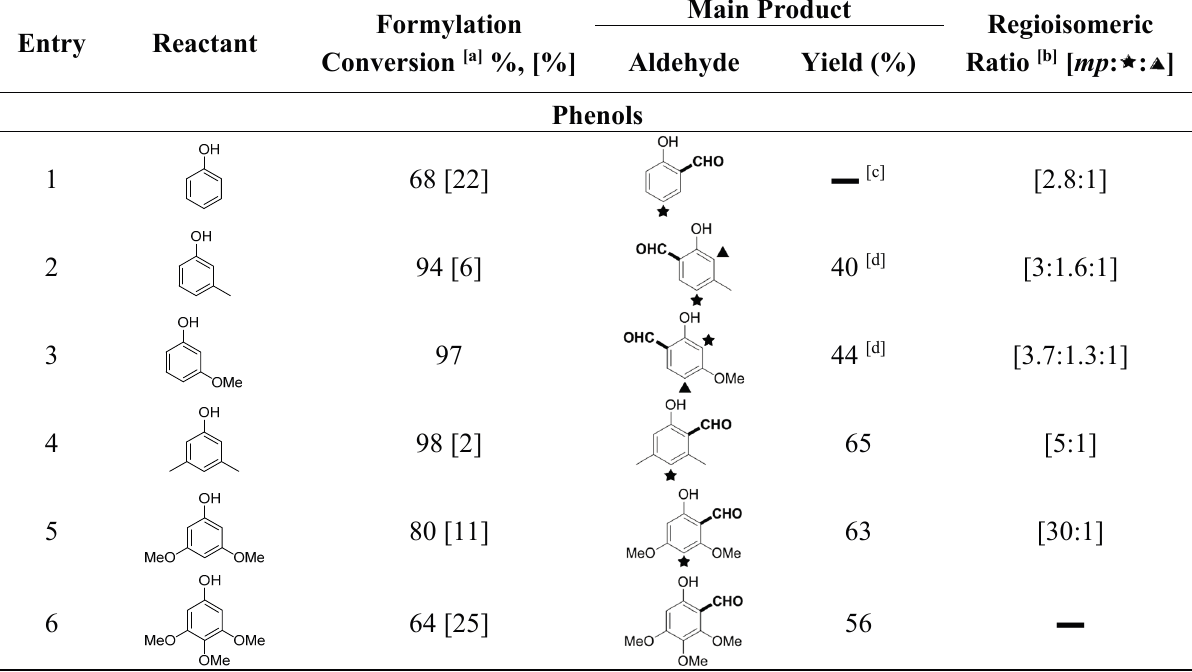
Table 1. Formylation of phenols, methoxy- and